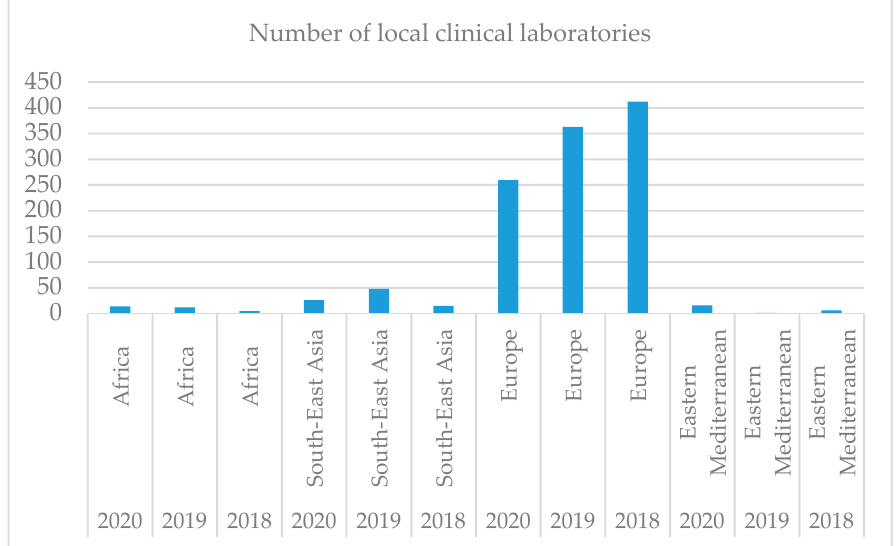
Figure 3. Number of clinical laboratories all over the world in 2018–2020. Over time, the number of clinical laboratories decreases in all regions except Europe, population and health personnel regarding clinical laboratories, which aids physicians